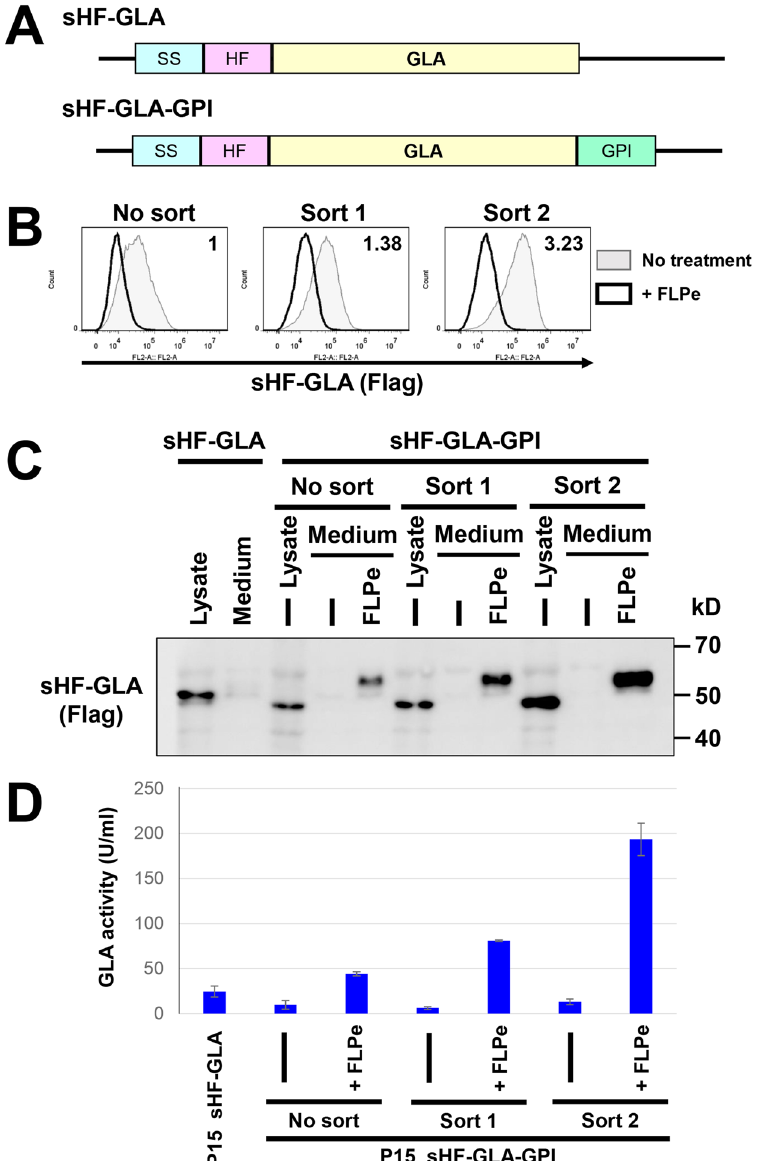
Figure 8. Selection of cells highly expressing GLA using the molecular switching system. ( A ) Schematic view of the plasmid constructs of the His6-Flag (HF)-tagged secretory GLA (sHF-GLA) and the GPI anchored GLA (sHF-GLA-GPI). The signal sequence (SS) and GPI attachment signal of human CD59 were used. ( B ) Sorting of cells highly expressing sHF-LIPA-GPI. P15 cells stably expressing sHF-GLA-GPI were sorted twice. Sorted cells were transfected with or without the vector carrying FLPe recombinase. Expression of sHF-GLA-GPI on the cell surface on the P15 cells expressing sHF-GLA-GPI before (No sort), after one round of sorting (Sort 1) or after two rounds of sorting (Sort 2) was analysed. Cells were stained with an anti-Flag antibody followed by a PE-conjugated goat anti-mouse IgG. ( C ) sHF-GLA in the cell lysate and culture medium was analysed. Culture medium from Sort 1 and Sort 2 cells with or without ( − ) treatment of FLPe recombinase were collected and precipitated. Proteins were detected by anti-Flag antibodies. The full image was included in the supplementary information. ( D ) GLA activity using cell culture medium. The medium was collected after culturing 2.5 × 10 5 cells for 48 h. GLA activities in the medium were measured by conversion of MU-Gal to 4-methylumbelliferone. The values shown are means ± SD of triplicate determinants. Results represent one of two comparable